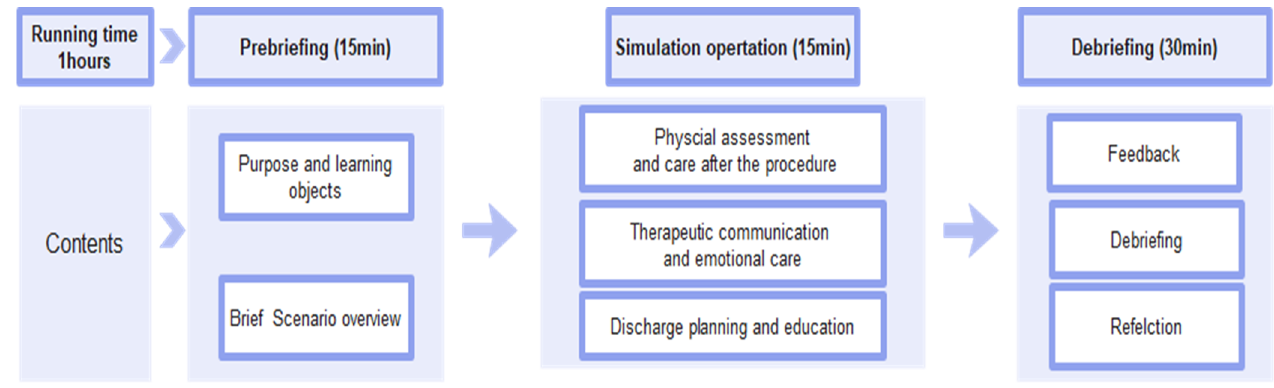
Figure 1. Detailed schedule of simulation.